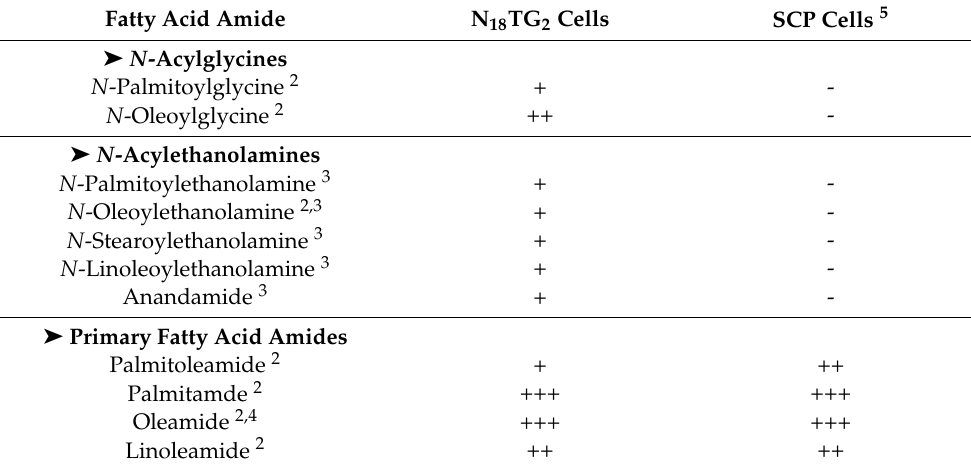
Table 1. Fatty acid amides produced by the mouse neuroblastoma N 18 TG 2 cells and sheep choroid plexus (SCP) cells 1